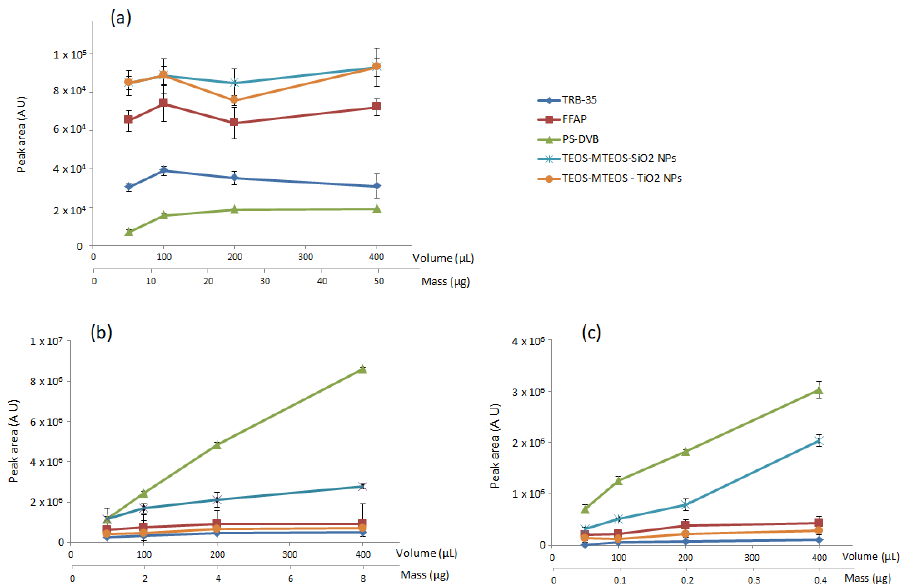
Figure 1. Effect of the sample volume (or mass of analyte introduced into the system) on the responses obtained with the different extractive capillary coatings tested for ( a ) saccharine (125 µ g/mL), ( b ) naphthalene (20 µ g/mL) and ( c ) fluoranthene (1 µ g/mL).